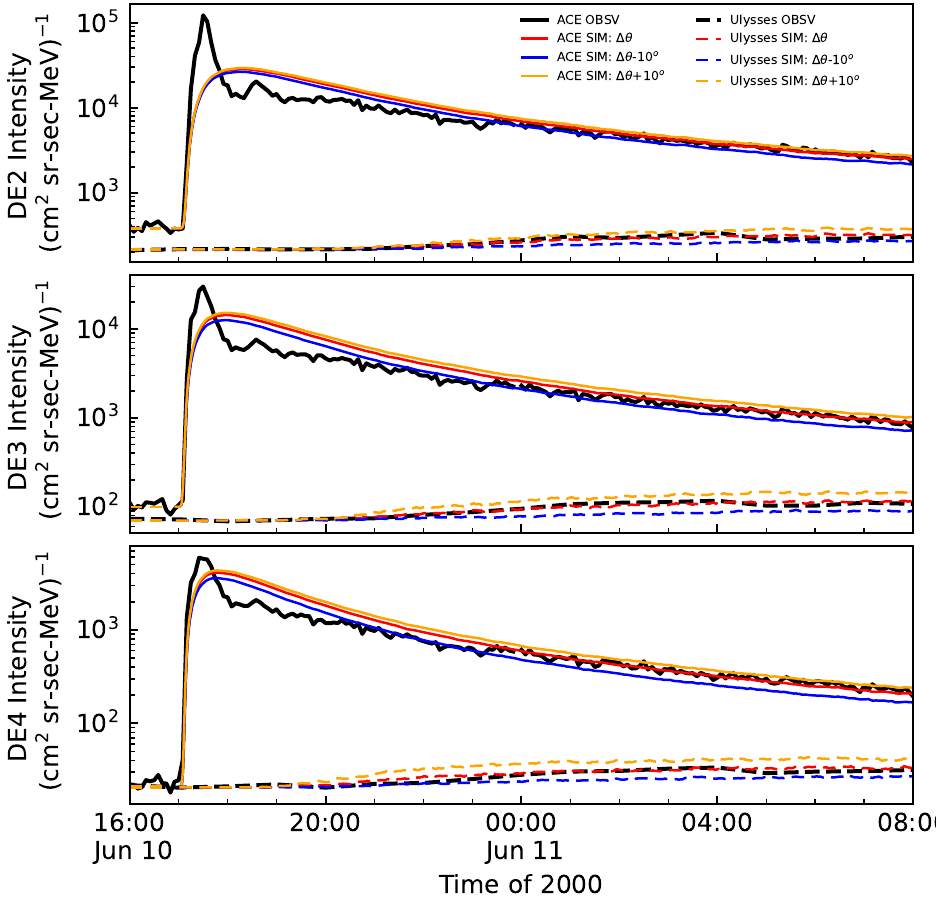
Figure 7. The SEP time-intensity profiles of 10 June 2000. The black lines indicate observations as measured by the spacecraft, and the red, blue, and orange lines indicate simulations with the best fit parameters, half width of a source 10 ◦ smaller or larger than the best fit parameters, i.e., ∆ θ − 10 ◦ and ∆ θ + 10 ◦ ,